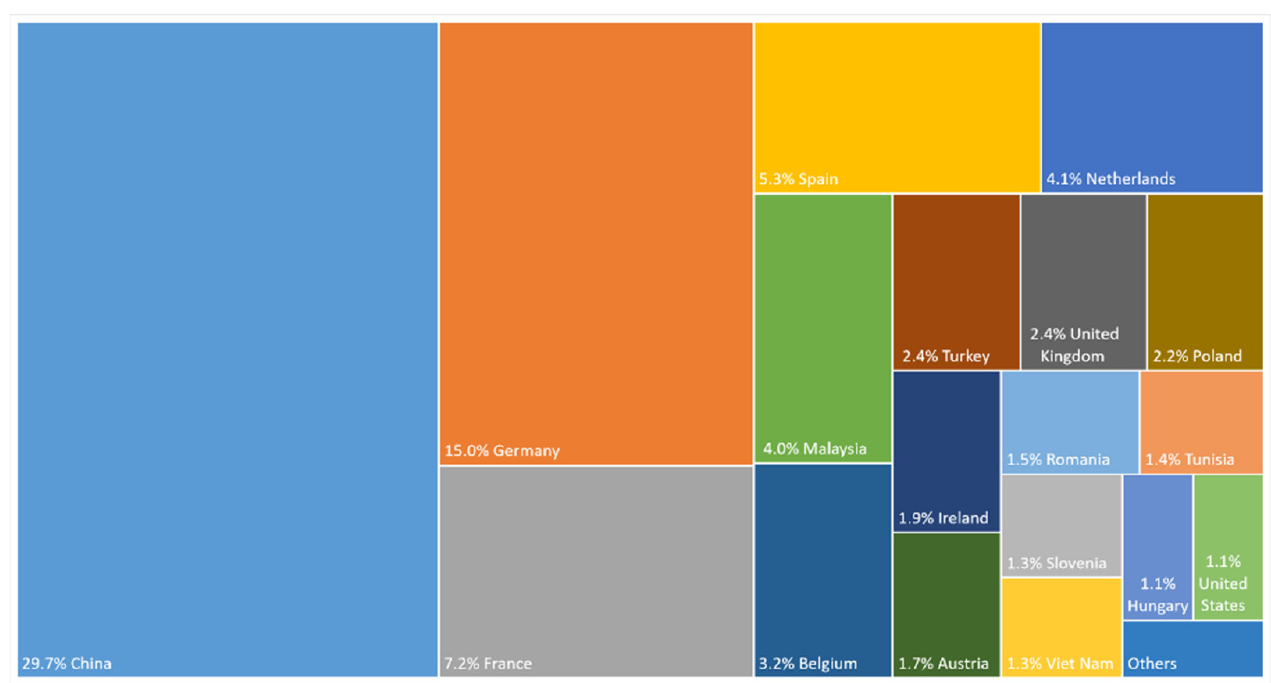
Figure 1. Euro values of imported personal protective equipment (PPE) in Italy, in 2020, expressed in %. Others includes the countries with % lower than 1%.